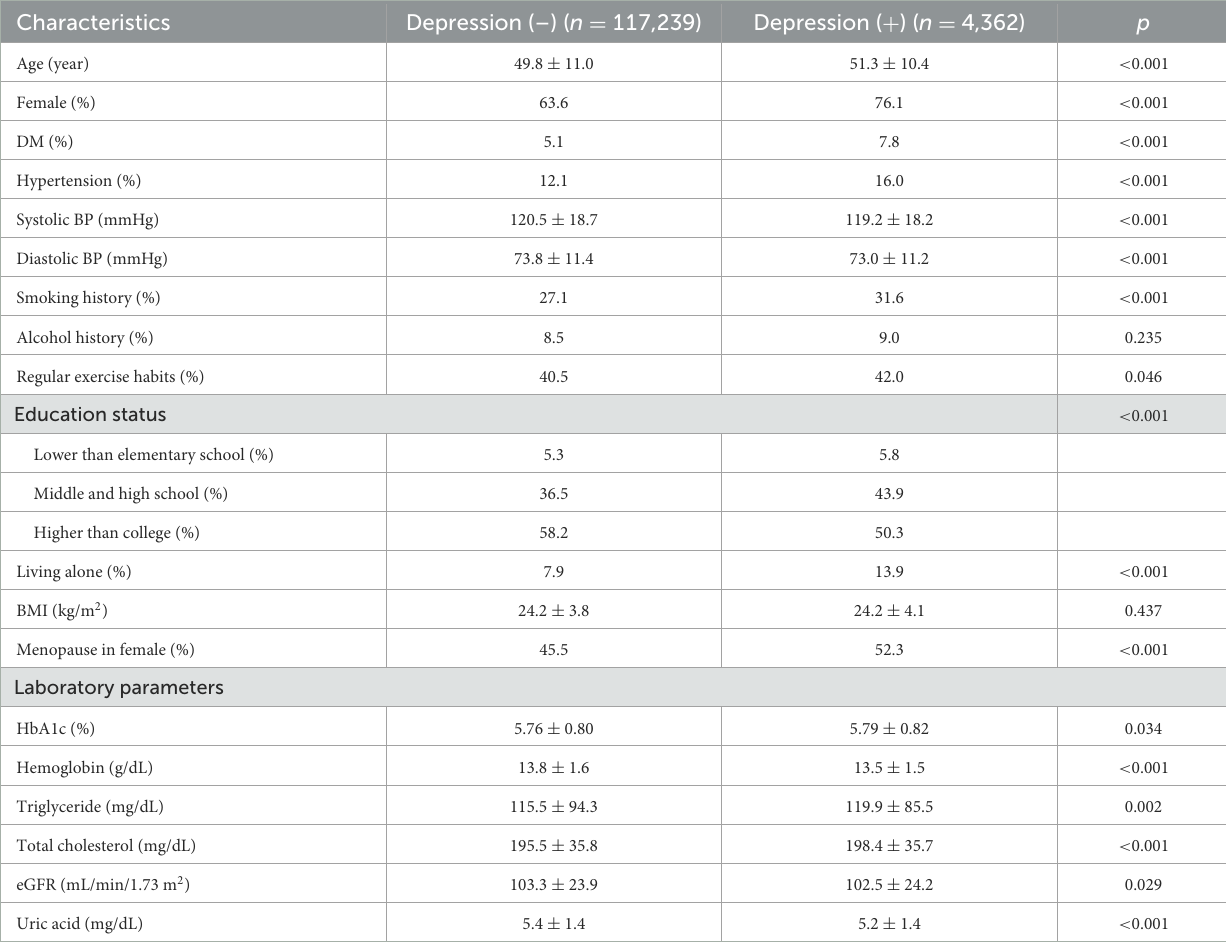
TABLE 1 Comparison of clinical characteristics among participants without or with depression.